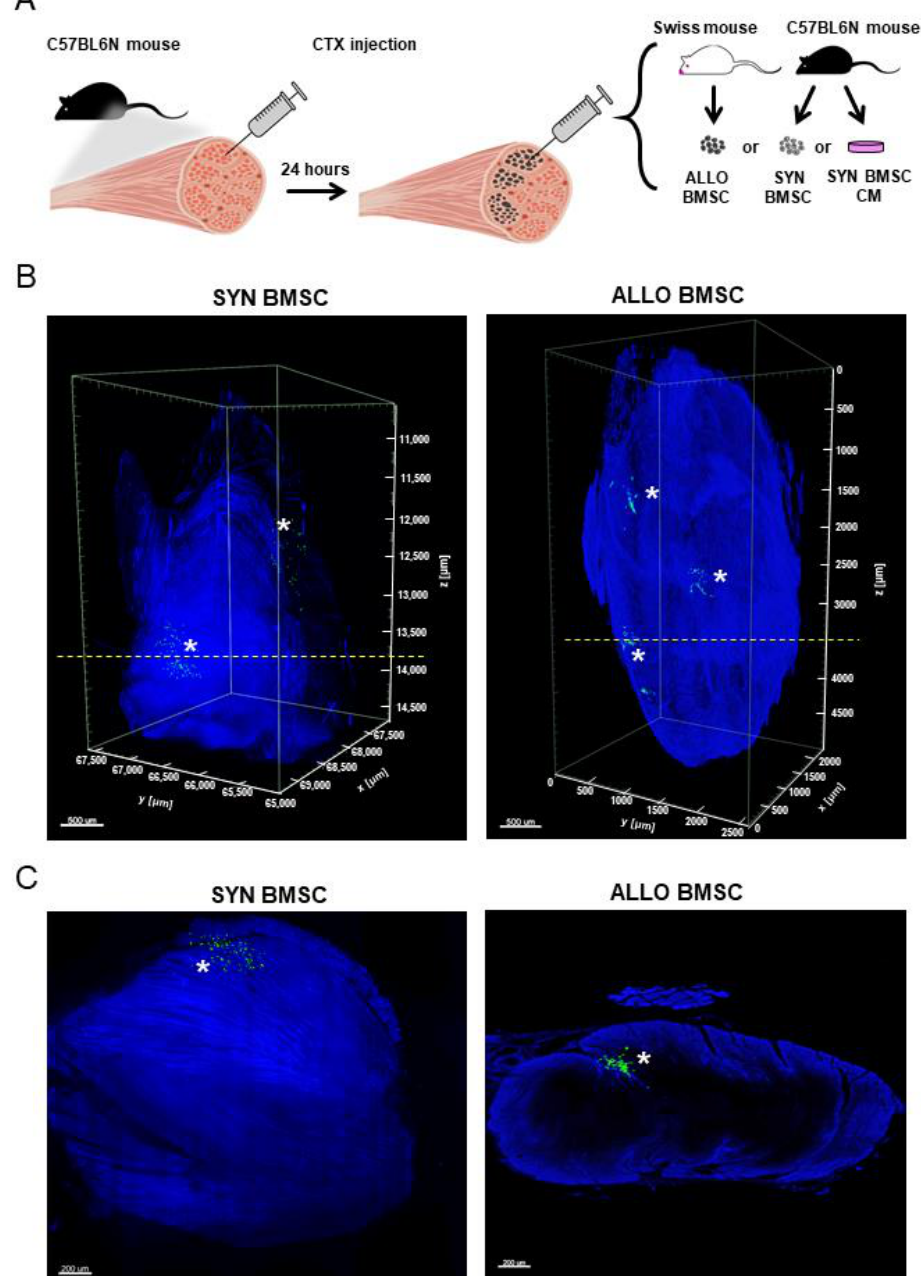
Figure 2. SYN or ALLO BMSC intramuscular injection. ( A ) Experimental procedure. ( B ) Whole muscle analysis and ( C ) optical sections of regenerating mouse skeletal muscles showing SYN and ALLO BMSC localization 14 days after muscle injury; images obtained with the iDISCO+ method; asterisks indicate localization of cells; SYN BMSCs or ALLO BMSCs are shown in green. Dashed lines visible on images in ( B ) indicate the plane of collection of optical sections shown in ( C ). For visualization of the entire muscle, myoglobin autofluorescence was collected (for each muscle treatment n =